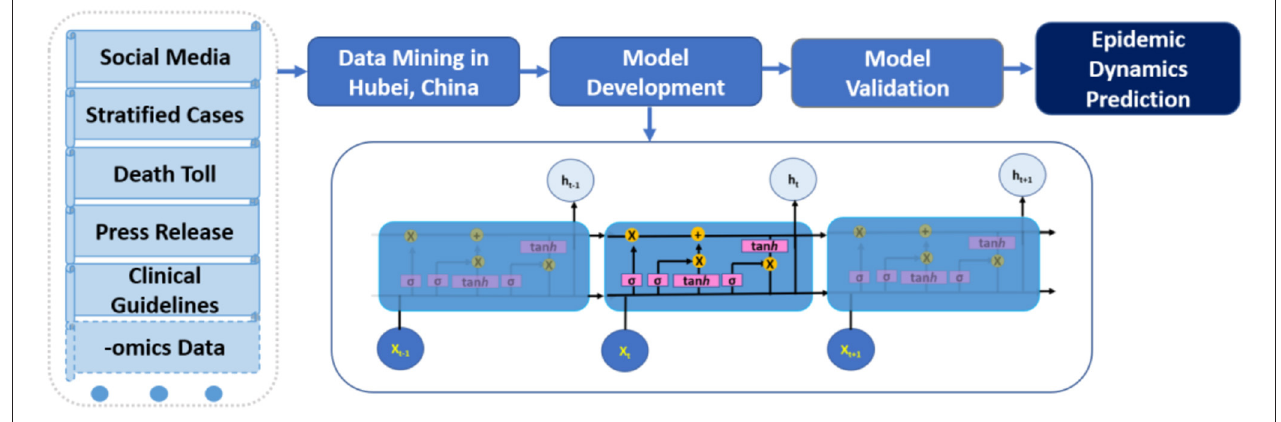
FIGURE 1 | Schematic data mining and multivariate deep learning (long short-term memory LSTM) workflow for COVID-19